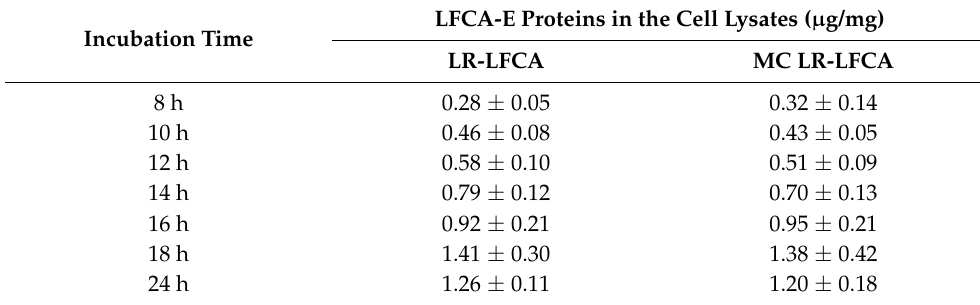
Table 7. Expression levels of LFCA-E proteins in the cell lysates.